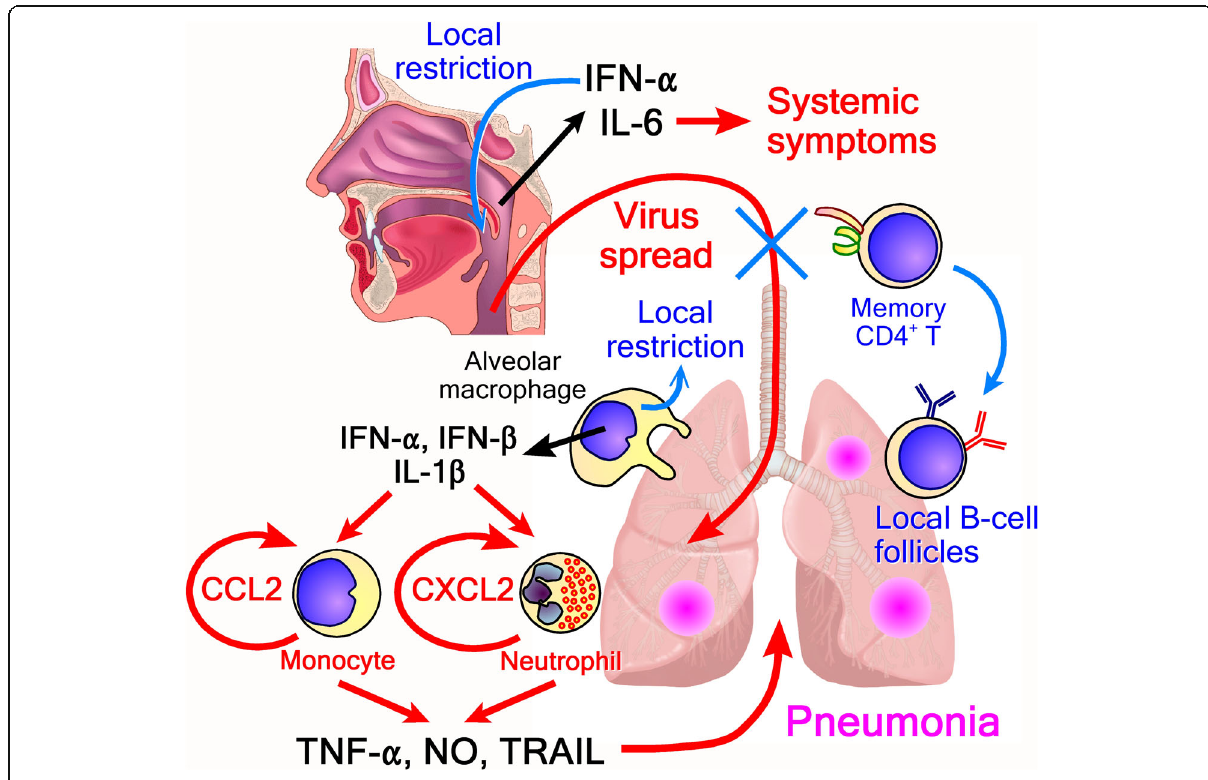
Fig. 2 Schematic representation of the pathogenesis of IAV-induced lung injury. See the main text for a detailed